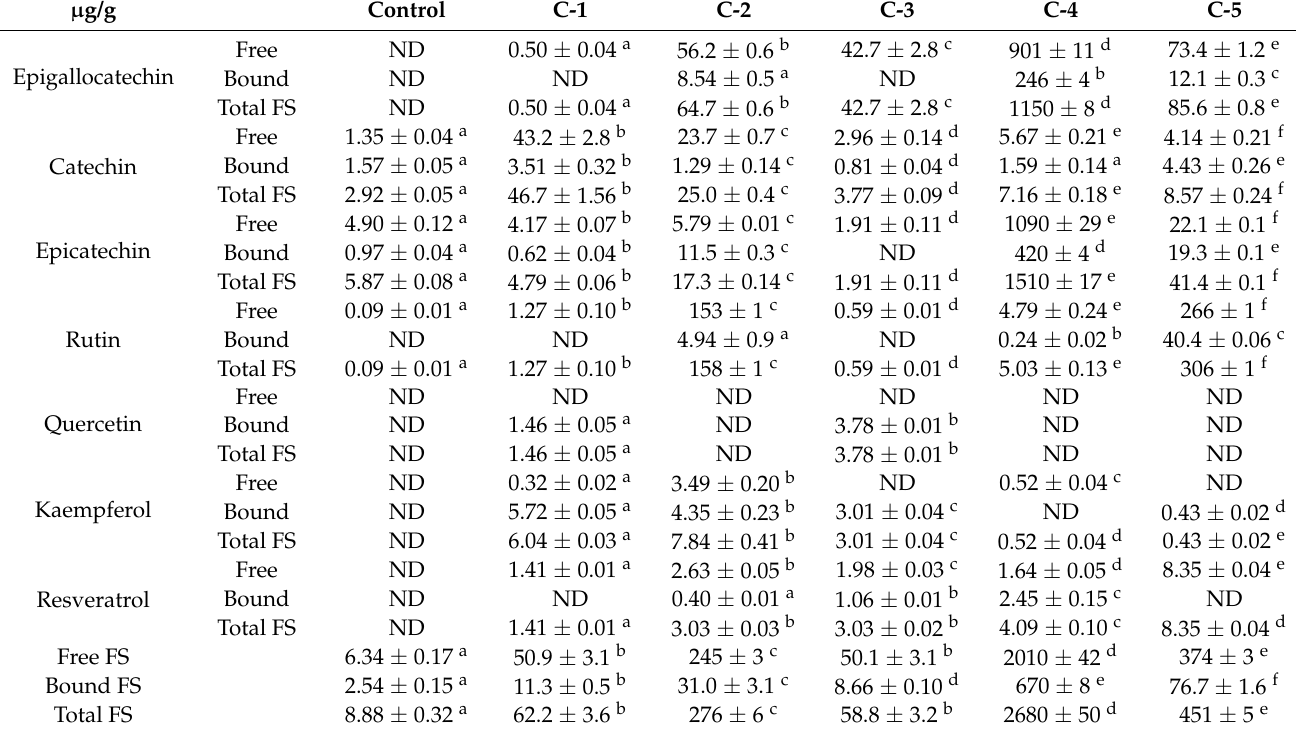
Results are presented as means ± SD ( n = 5) on dry weight basis. Values followed by the different letters in the same line are significantly different ( p < 0.05). ND = not detected. Free FS: flavonoids and stilbenes in free phenolic fraction; bound FS: flavonoids and stilbenes in bound phenolic fraction; total FS: total flavonoids and